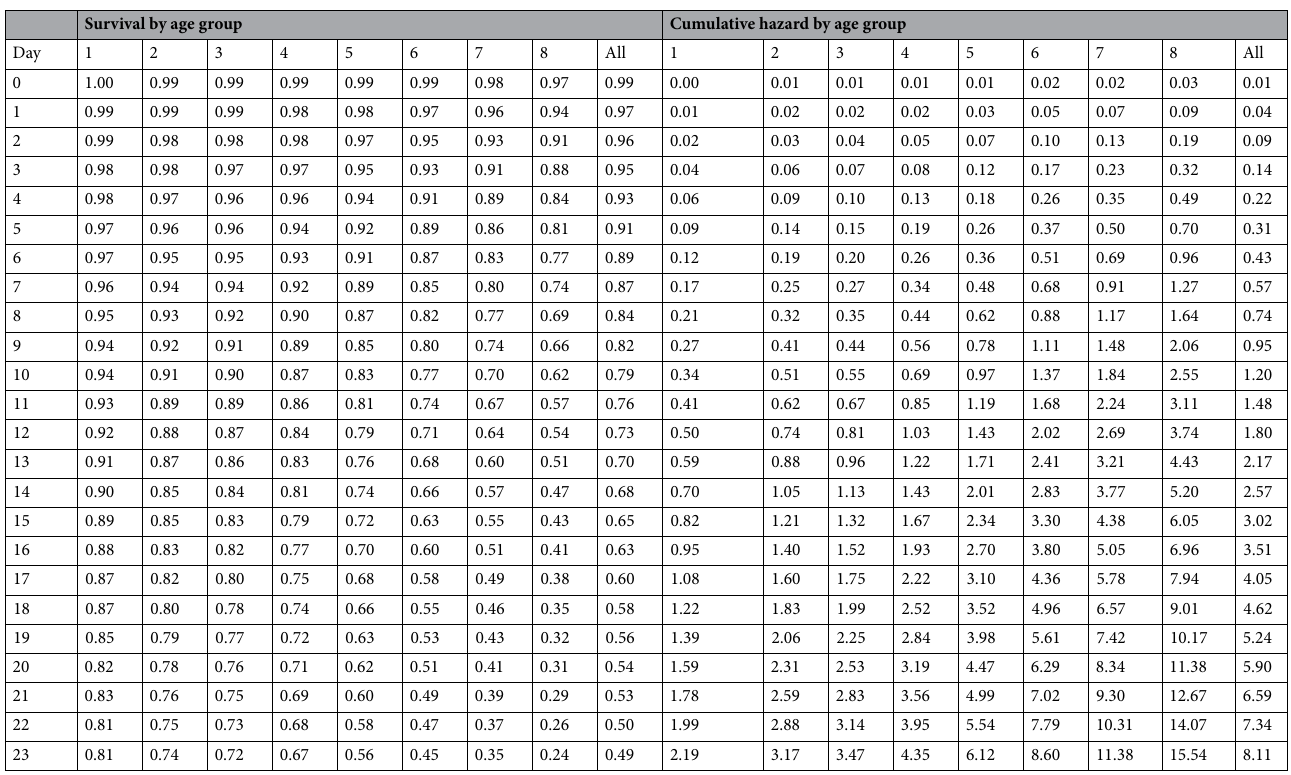
Table 3. Hospitalization survival and hazard by age group. Note: 1: 0–17, 2: 18–29, 3: 30–39, 4: 40–49, 5: 50–64, 6: 65–74, 7: 75–84, and 8: ≥ 85